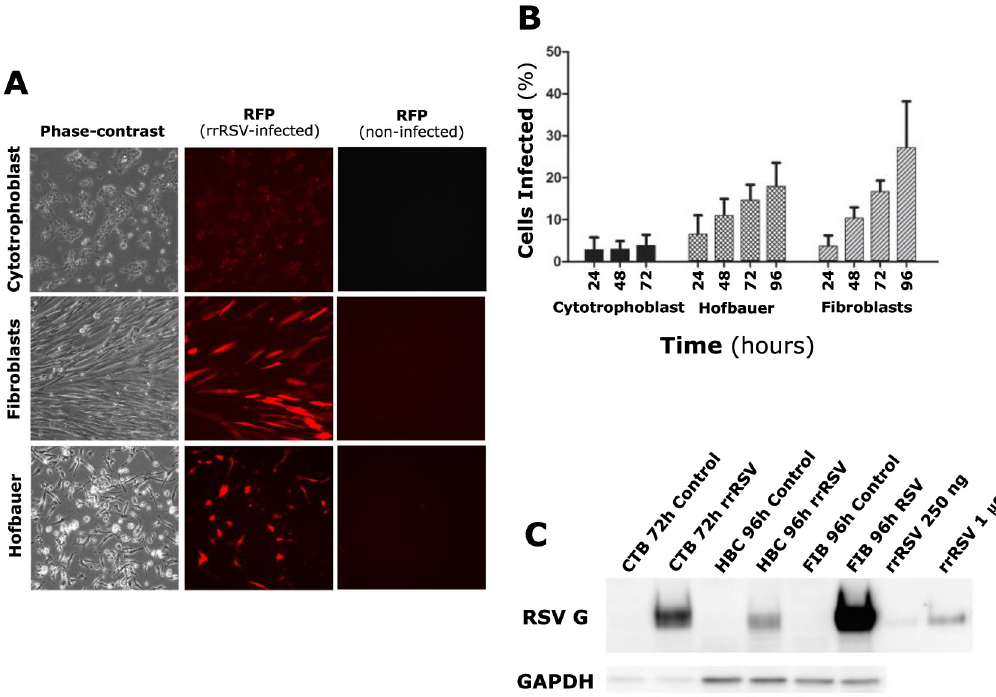
Fig 1. RSV infection of primary human placental cells. (A) Isolated human placental cells (left panels) after 72 hours (cytotrophoblast cells) or 96 hours (fibroblast and Hofbauer cells) infection at MOI of 1.0 with an RSV-A2 strain (rrRSV) expressing red fluorescent protein (RFP). Strong RFP expression resulting from rrRSV replication was observed in fibroblast and Hofbauer, but not in cytotrophoblast cells (center panels). Matched non-infected controls did not exhibit any fluorescence (right panels). (B) Proportion of cytotrophoblast, fibroblast, and Hofbauer cells exhibiting red fluorescence as a result of rrRSV replication. Each time-point represents the mean ± SEM of 8 different fields. (C) Expression of RSV G protein in cytotrophoblast (CTB), Hofbauer (HBC), and fibroblast (FIB) cells infected with rrRSV and processed at 72 or 96 hours for Western blot analysis. rrRSV lysate was used in two different concentrations (250 ng and 1 μ g) as a positive